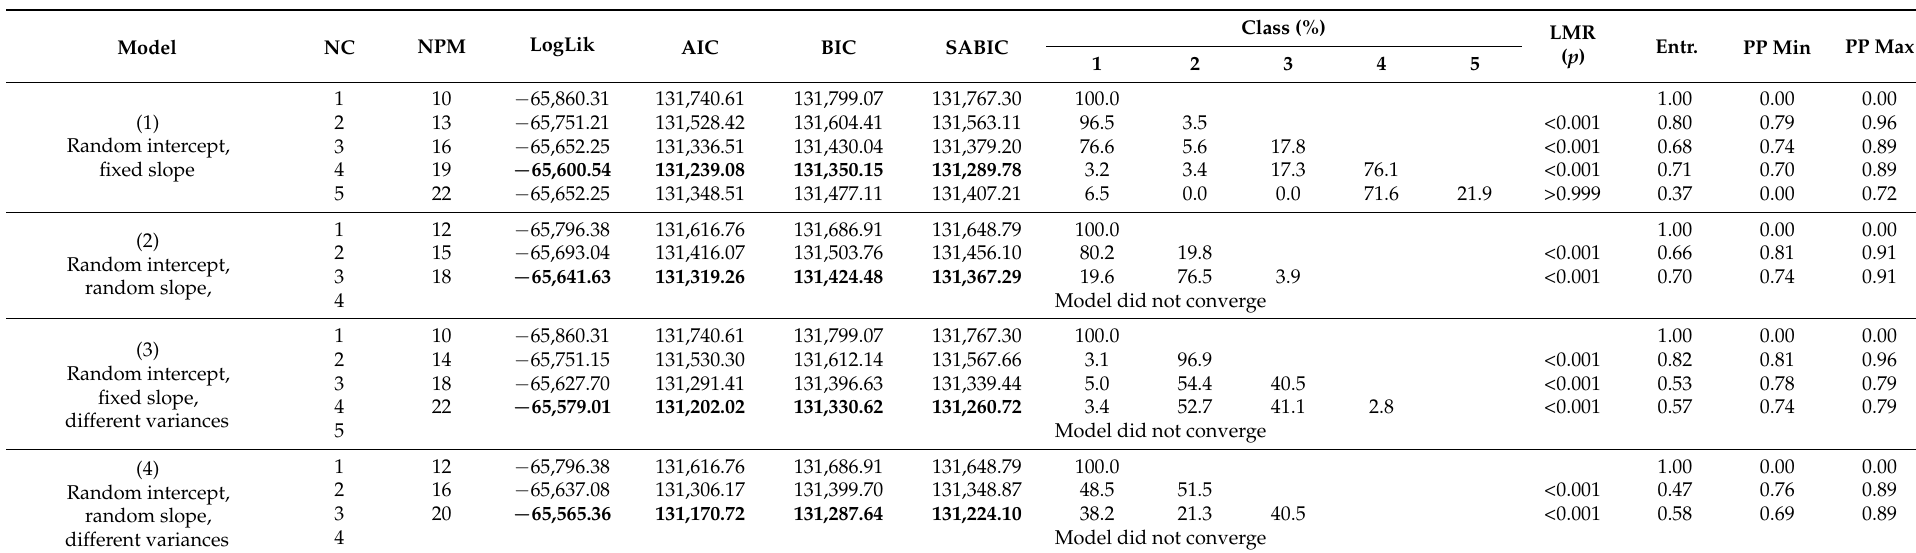
Table A3. Multivariate Latent Class Growth Analysis for QoLIBRI-OS and SF-12v2 MCS/PCS ( N =